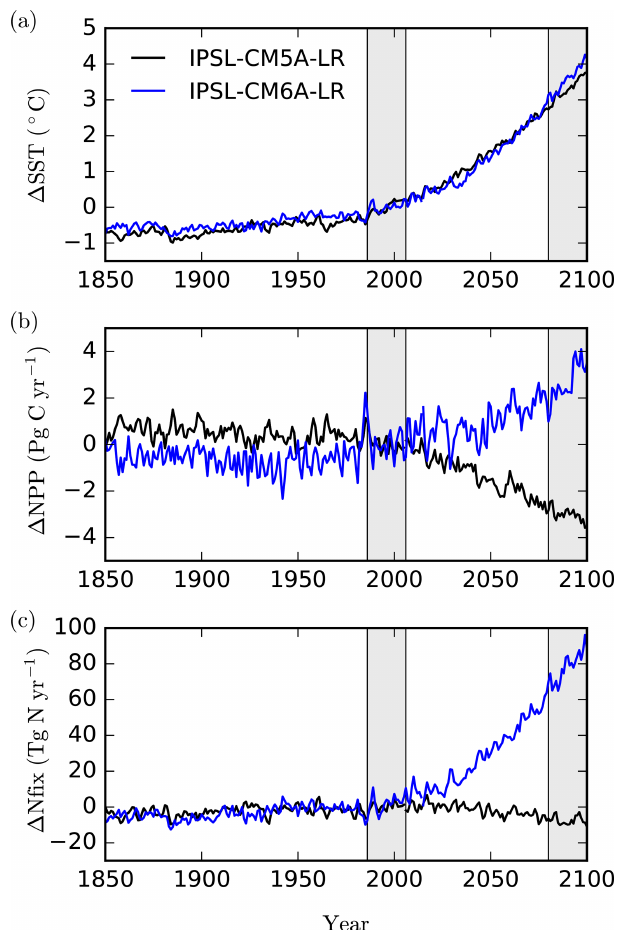
Figure 1. Simulated changes relative to 1986–2005 in (a) sea surface temperature ( ◦ C), (b) integrated net primary production (PgCyr − 1 ) and (c) integrated N 2 fixation (TgNyr − 1 ), for IPSL- CM5A-LR (black) and IPSL-CM6A-LR (blue) over historical and future scenarios. Note that the RCP8.5 emission pathway is used for IPSL-CM5A-LR, but SSP5-8.5 is used for IPSL-CM6A-LR. The historical and future periods (1986–2005 and 2080–2099, respec- tively) are displayed as grey